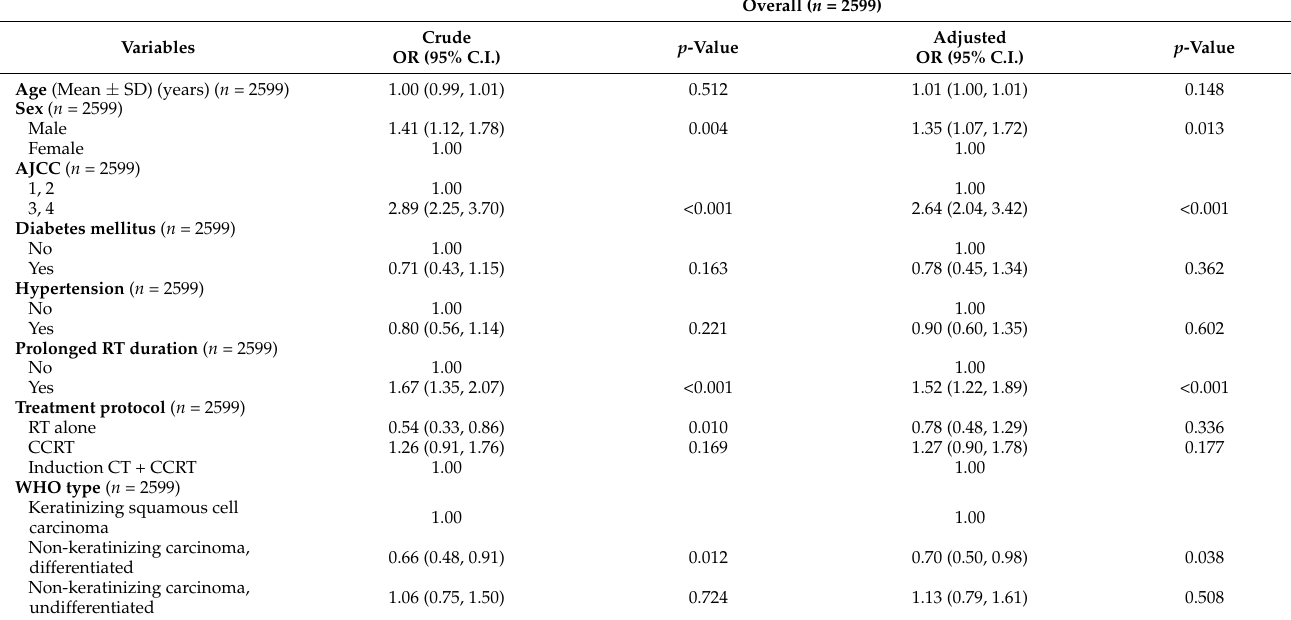
Table 2. Logistic regression of independent risk of recurrent